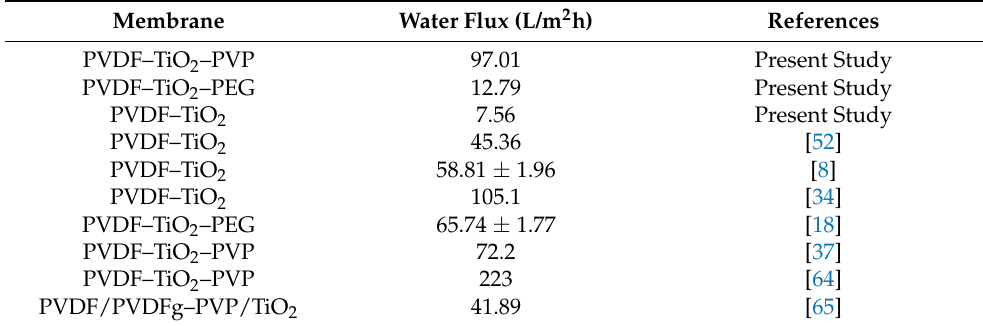
Table 6. Mixed-Matrix Membranes Water Flux Comparison in This Work and Previous Studies.